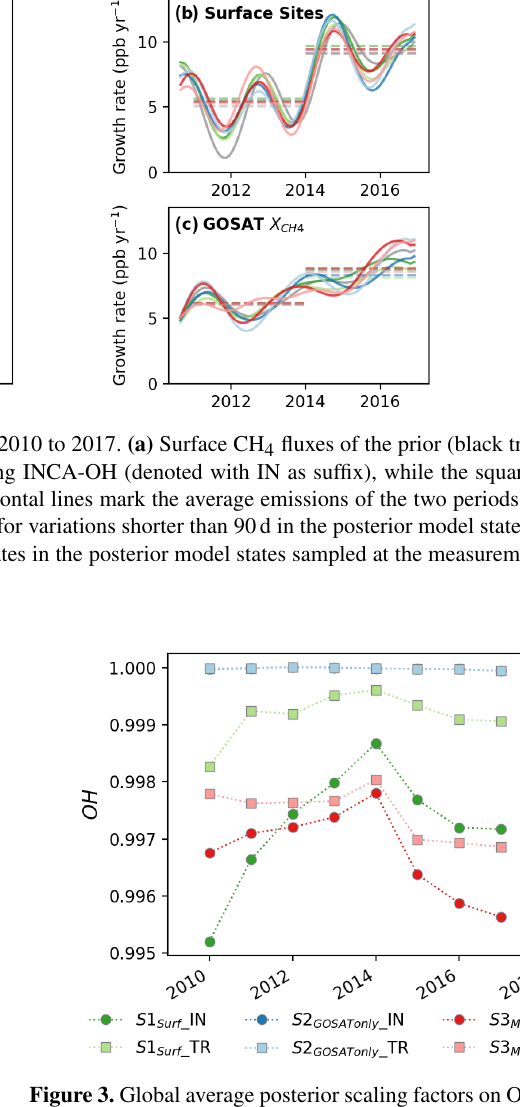
Figure 3. Global average posterior scaling factors on OH. Note that OH is only optimized by the system if other tracers in addition to CH 4 are assimilated (S1 and